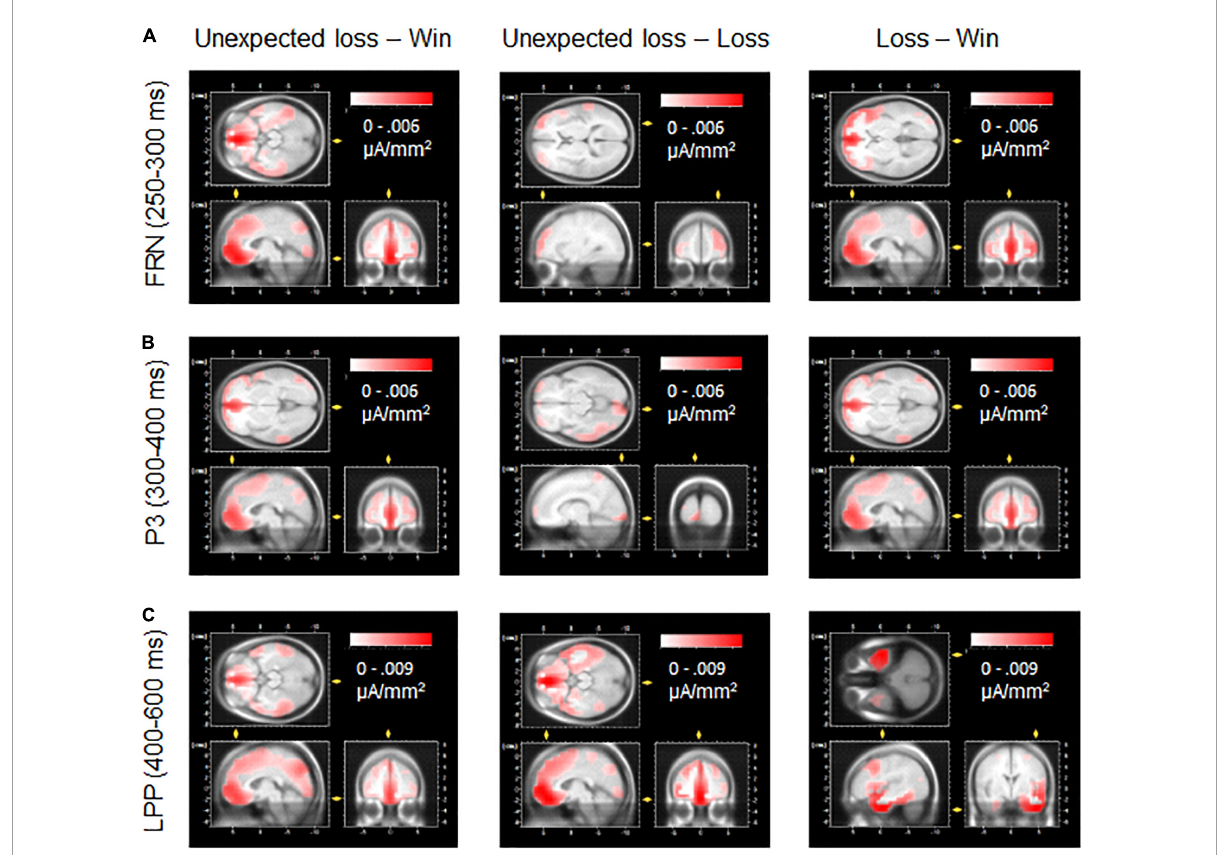
FIGURE5 LORETA source estimations for the differential effects of feedback types as revealed by the FRN, P3, and LPP components. The medial frontal gyrus and anterior cingulate emerged as relevant sources for the FRN (A) and P3 (B) components discriminating negative compared to positive feedback. (C) For the LPP, frontal lobe and orbital gyrus best-matched the differential cortical activity to unexpected loss vs. loss and win feedback. For the LPP difference loss vs. win, the best source match referred to the temporal lobe and inferior temporal